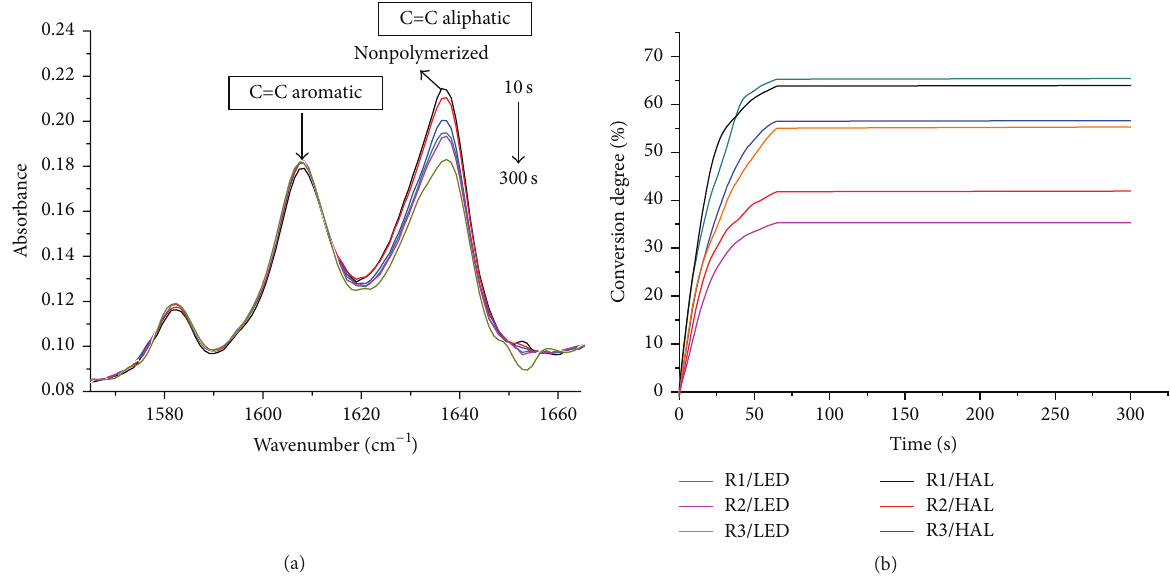
Figure 1: (a) Real-time FT-IR spectrum of the carbon double bond conversion for the peak corresponding to the aliphatic chains. (b) Graph with the real-time DC for resins using LED and halogen lamp